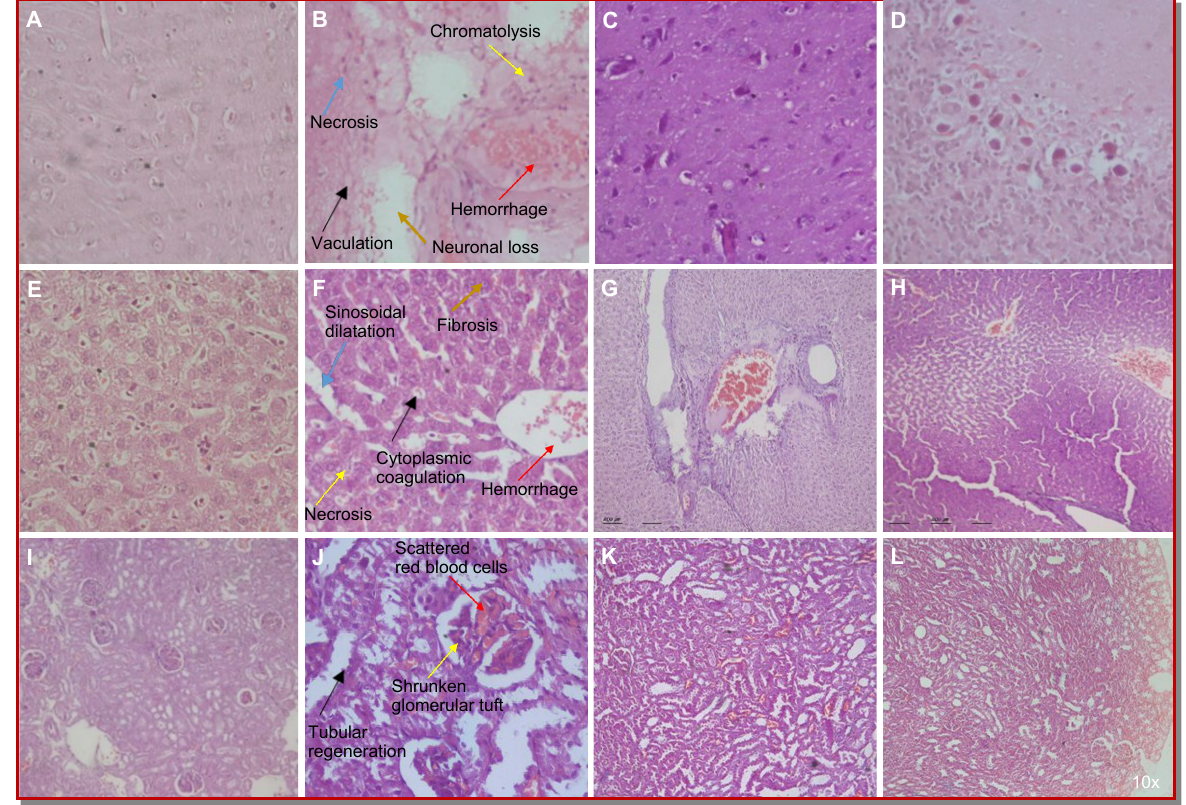
Figure 1: Histopathology of the brain (A-D), liver (E-H) and kidney (I-L) of sodium arsenite-induced hepatotoxicity Longitudinal sections were taken and a Leica microtome was used to cut the paraffin block to a 4-5 µm thickness. After H&E staining the slides are viewed under the light microscope. Group description, A, E, I) Group I – normal control; B, F, J) Group II - Sodium arsenite control (40 mg/kg); C, G, K) Group III – Sodium arsenite (40 mg/kg) + Phyllanthus amarus (100 mg/kg; D, H, L) Group IV - Sodium arsenite (40 mg/kg) + P. amarus (200 mg/kg). Pathological findings and arrows indicating them in the picture have the same color and different colors indicate different pathological findings. Magnification of the lens is mentioned in white color. Camera used – Zeiss